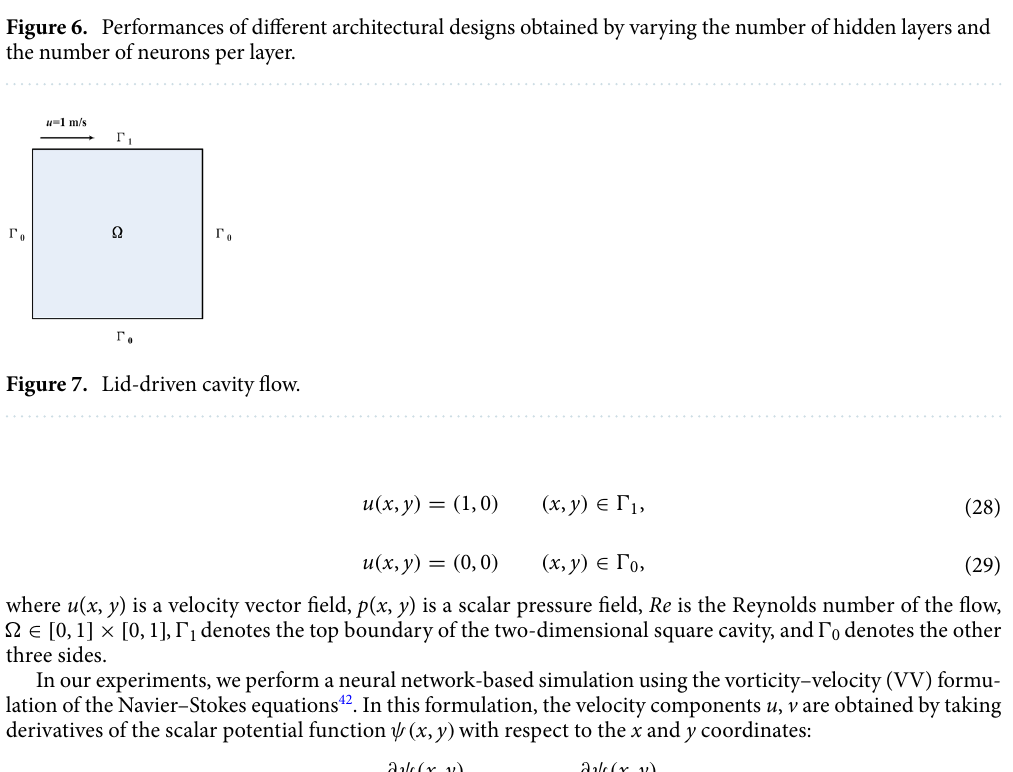
Figure 6. Performances of different architectural designs obtained by varying the number of hidden layers and the number of neurons per layer.